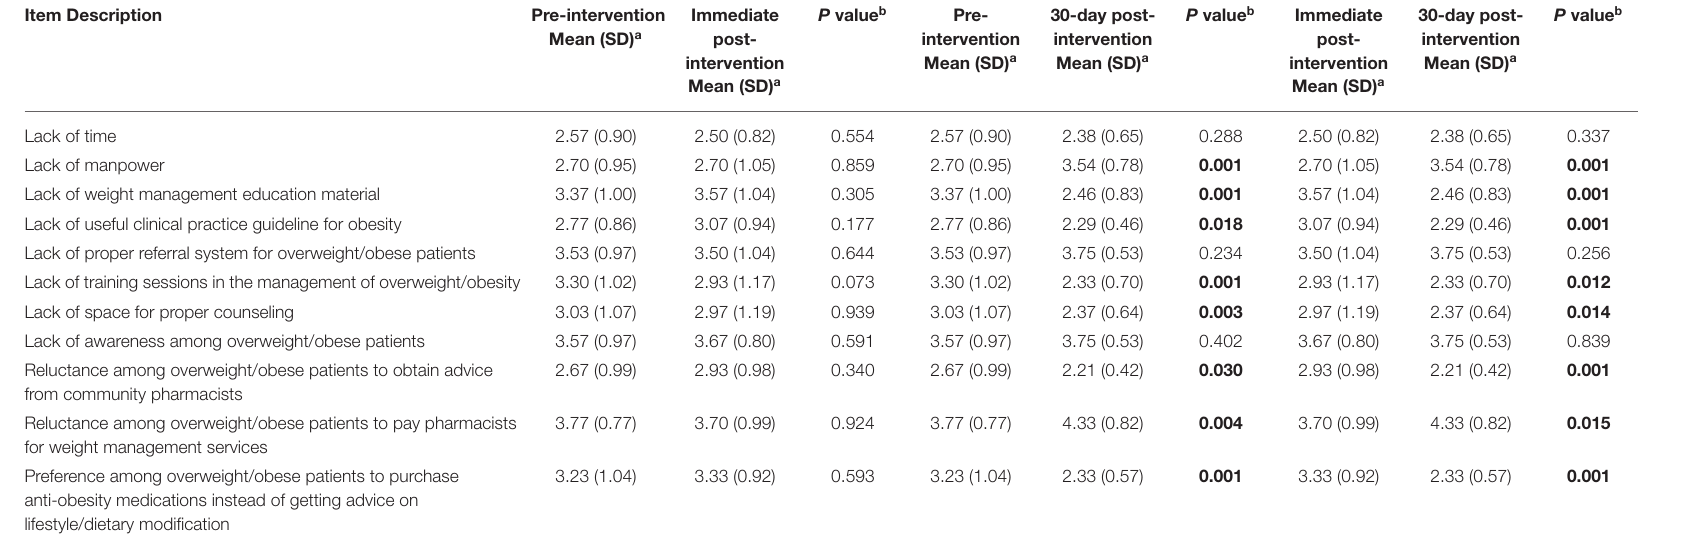
TABLE 4 | The impact of the intervention on perceived barriers of participants towards weight management